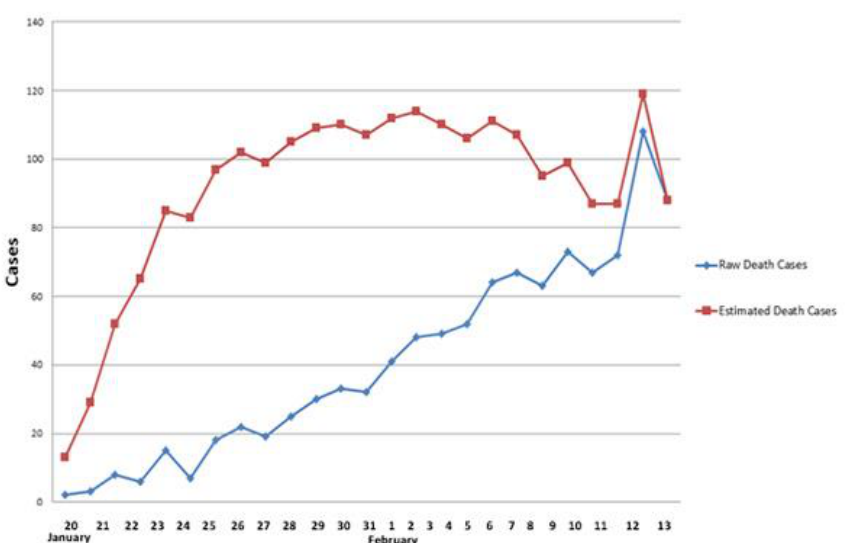
Figure 11. Original and estimated death numbers in Wuhan from 20 January to 13 February 2020. The revised mortality rates of Wuhan during different transmission stages are illus- trated in Figure 12.